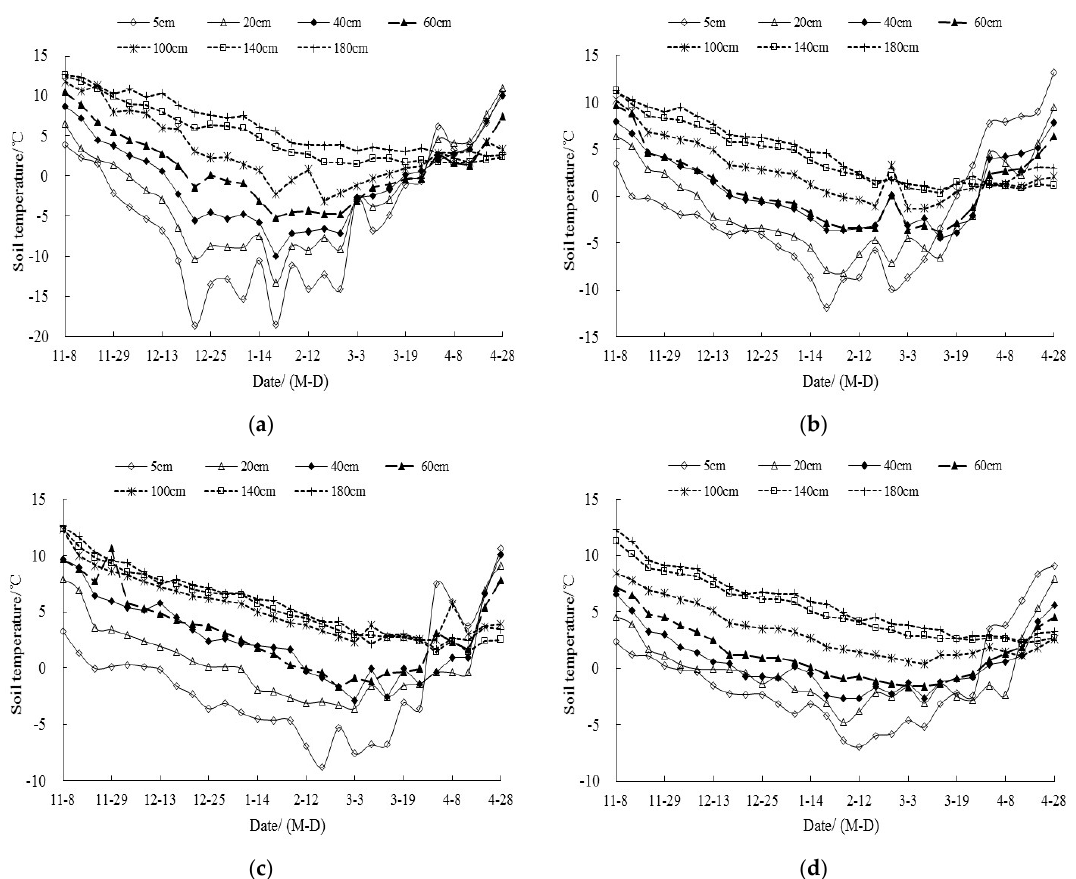
Figure 5. Variation in soil temperature under different snow covers. ( a ) Bare land; ( b ) natural snow; ( c ) compacted snow; ( d ) thick snow.